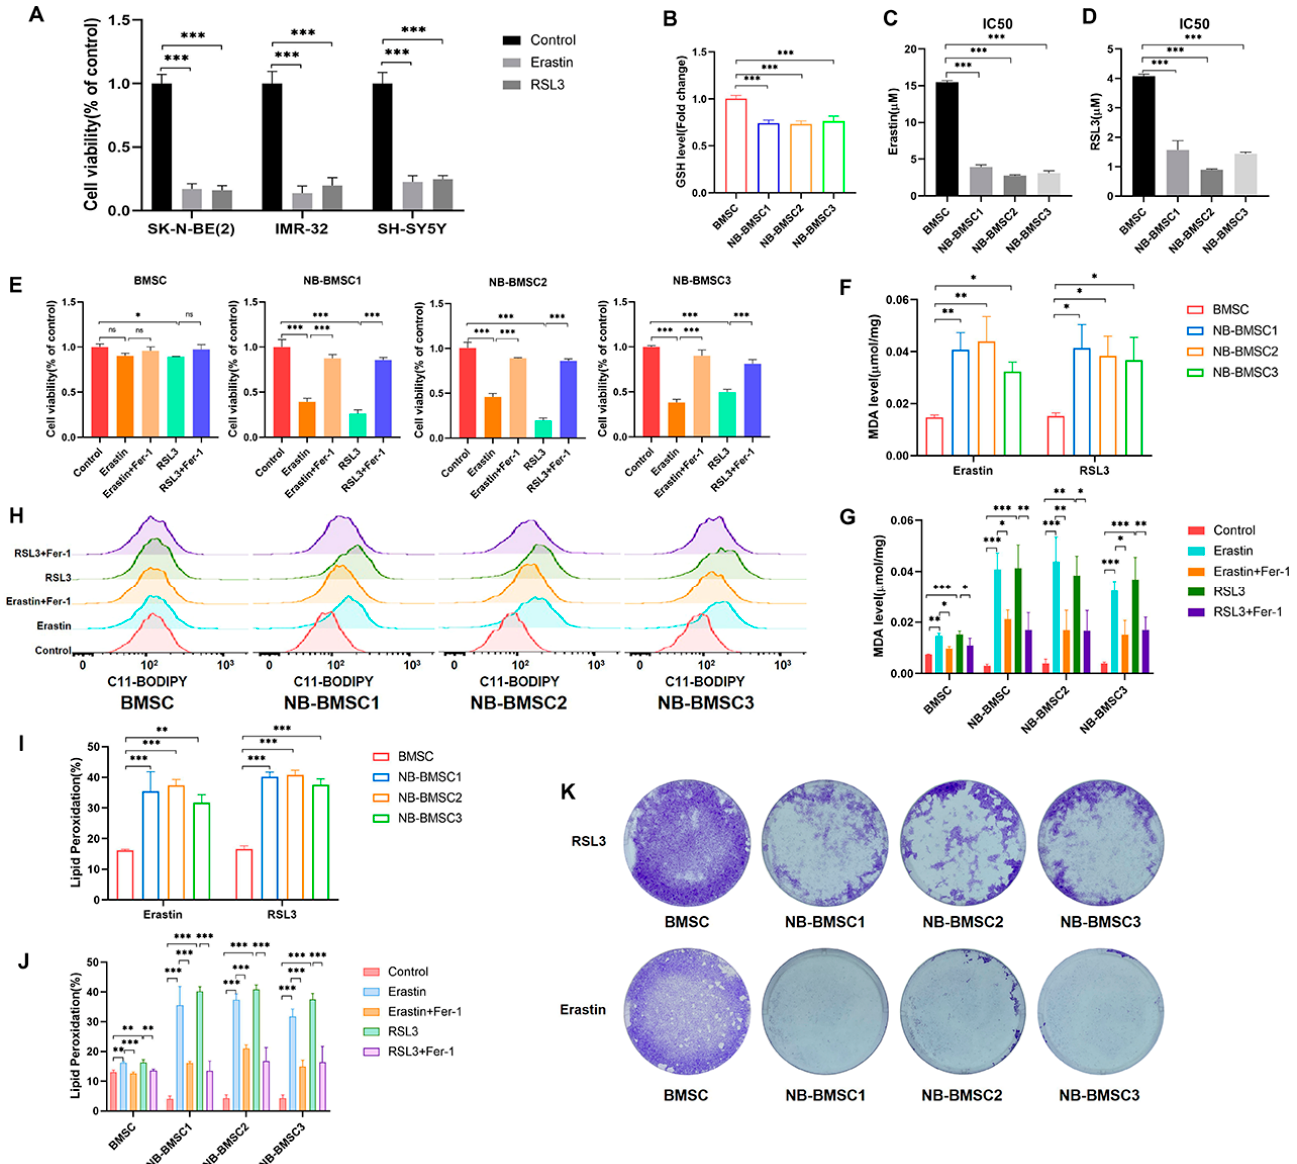
Figure 5. NB-BMSCs had lower anti-ferroptosis capacity. ( A ) CCK8 assay was performed to assess NB cell viability under 4 µ M erastin and 2 µ M RSL3 treatment. ( B ) GSH level of normal BMSCs and NB-BMSCs was examined. ( C , D ) We detected the IC50 of erastin and RSL3 on normal BMSCs and NB-BMSCs. ( E – J ) 4 µ M erastin and 2 µ M RSL3 was used to treat normal BMSCs and